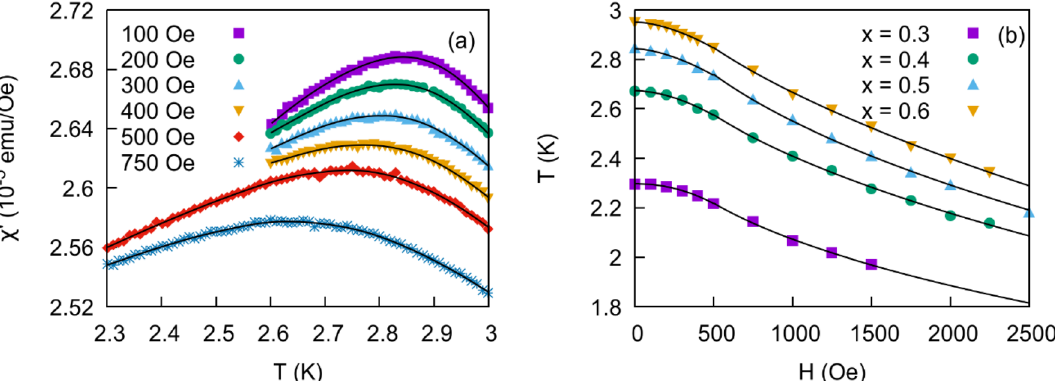
0.5 . Peak in χ ′ broadens and shifts to lower temperatures in higher external dc Figure 8. (a) χ ′ versus T for x = fields. (b) T f vs H shows AT like behavior above 500 Oe for all members of the solid